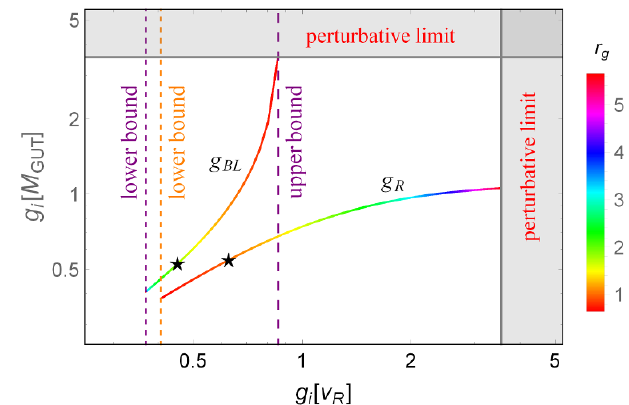
Figure 5 . Correlation of g R;BL ( v R ) and g R;BL ( M GUT ) in the minimal LRSM as functions of r g = g R =g L at the v R scale (as shown by the color coding). The shaded regions are excluded by p the perturbativity limits g R;BL < 4 (cid:25) . The two stars correspond to the special case g R = g L at the v R scale. The vertical dotted and dashed lines respectively denote the lower and upper limits on the gauge couplings. Here we have chosen v R = 10 TeV and M GUT = 10 16 GeV. Note the change in sign for (cid:12) ( g ), as compared to eq. (3.1), which is due to the R